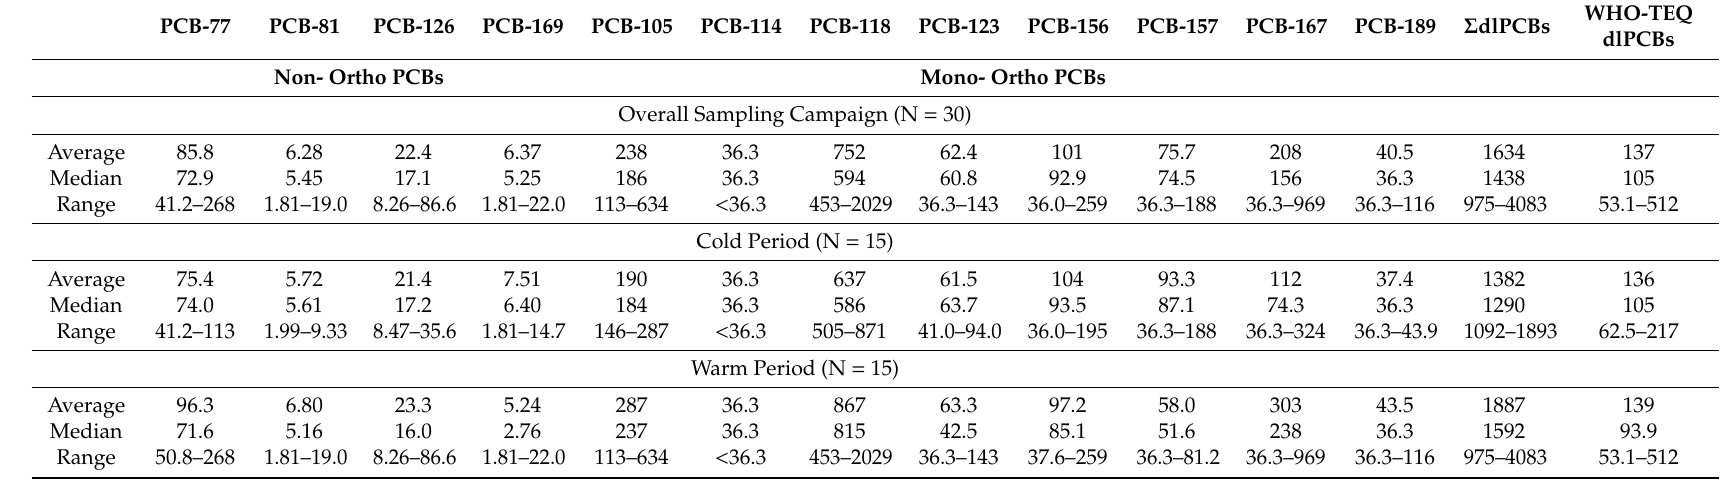
Table 4. Average, median, and ranged concentrations of dioxin like PCBs (dlPCBs) (fg m − 3 ) for the overall and seasonally divided sampling